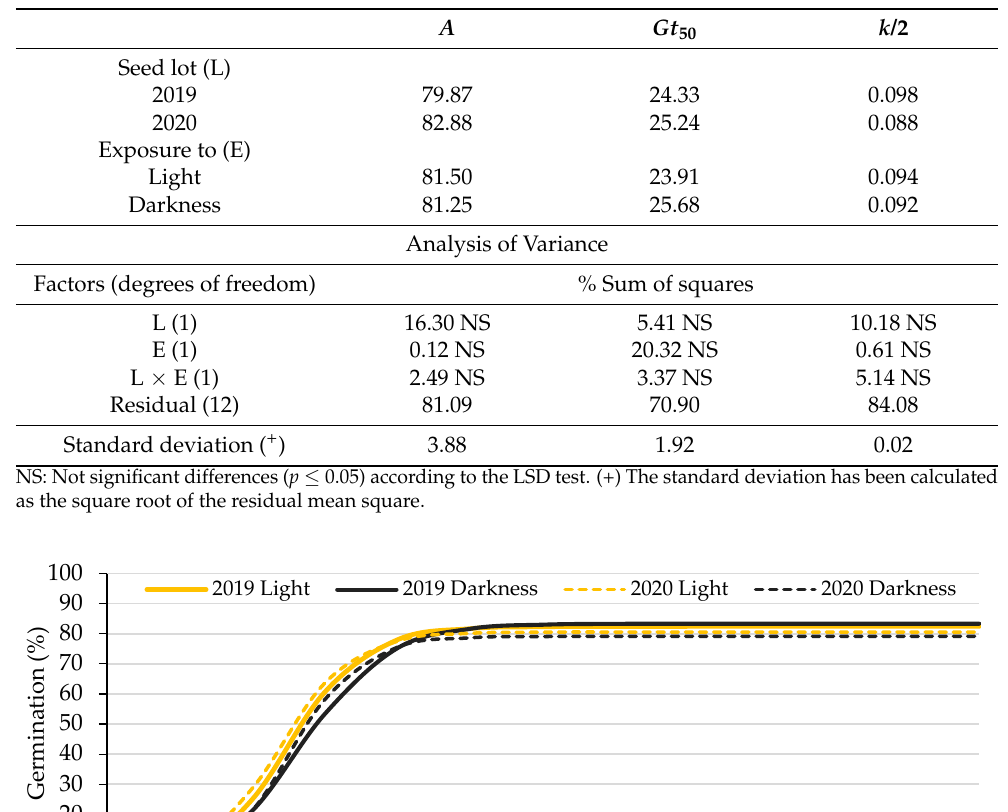
Table 2. Effect of the seed lot and the exposure to light–darkness on the germination parameters: final germination percentage ( A , %), time required to reach 50% of final germination ( Gt 50 , d), and average germination rate ( k /2; d − 1 ); average values from Experiment 1. A 500 mg L − 1 GA 3 solution was used to wet the substrate.